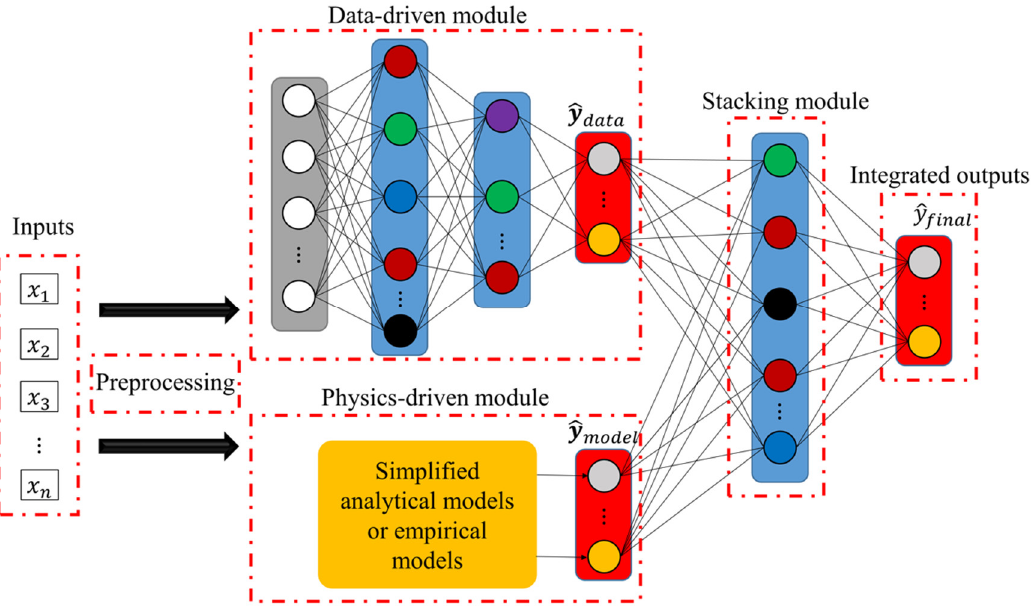
Figure 3. A simple strategy to integrate analytical/empirical models with data-driven